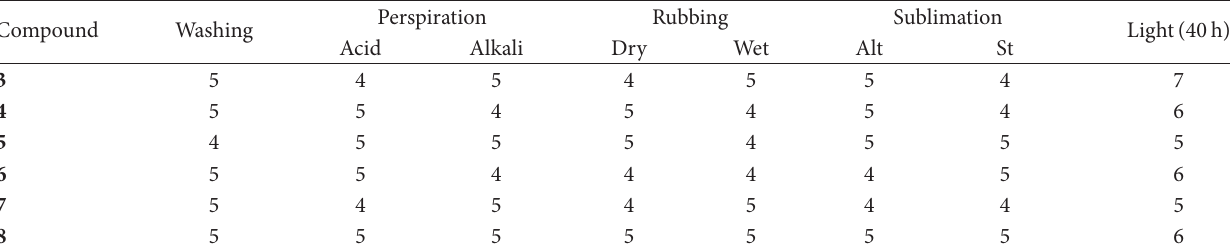
T 1: Fastness properties of dyes 3 – 8